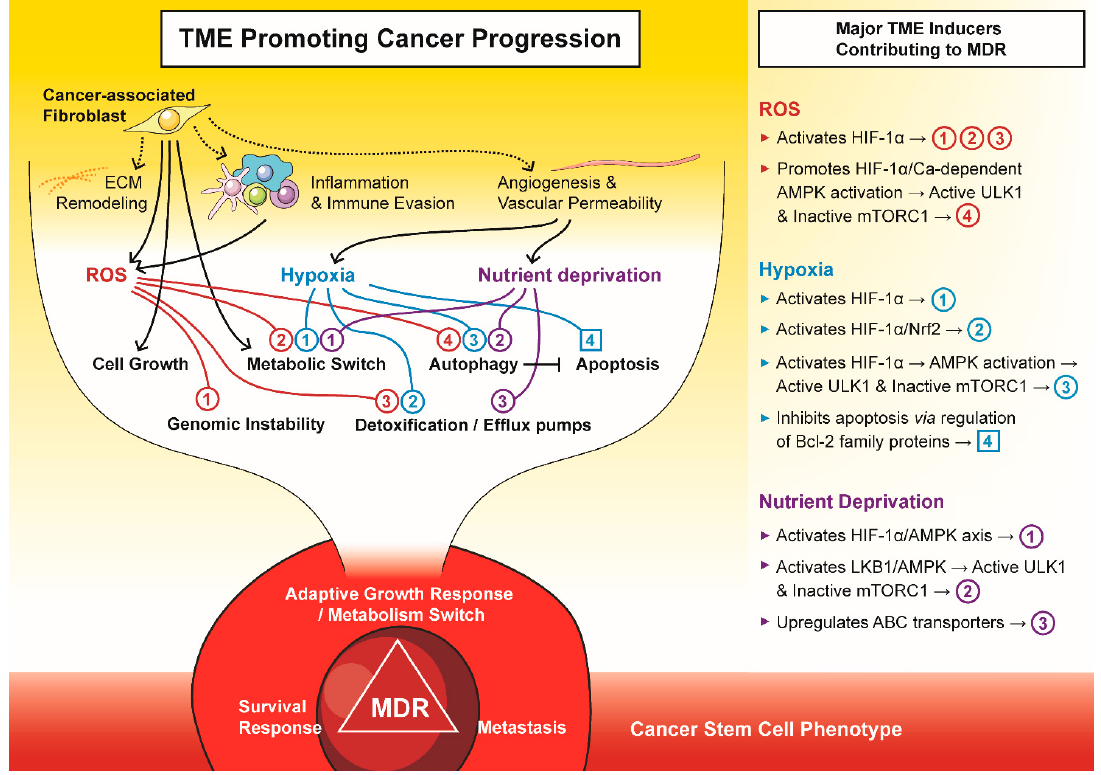
Figure 2. The tumour microenvironment (TME) promotes cancer progression to a multi-drug resistant (MDR) phenotype. The major components of TME, i.e., cancer-associated fibroblasts, reactive oxygen species (ROS), hypoxia, and nutrient deprivation, drive tumours to an adaptive growth, survival and metastatic phenotype that is often attributed to cancer stem cells.